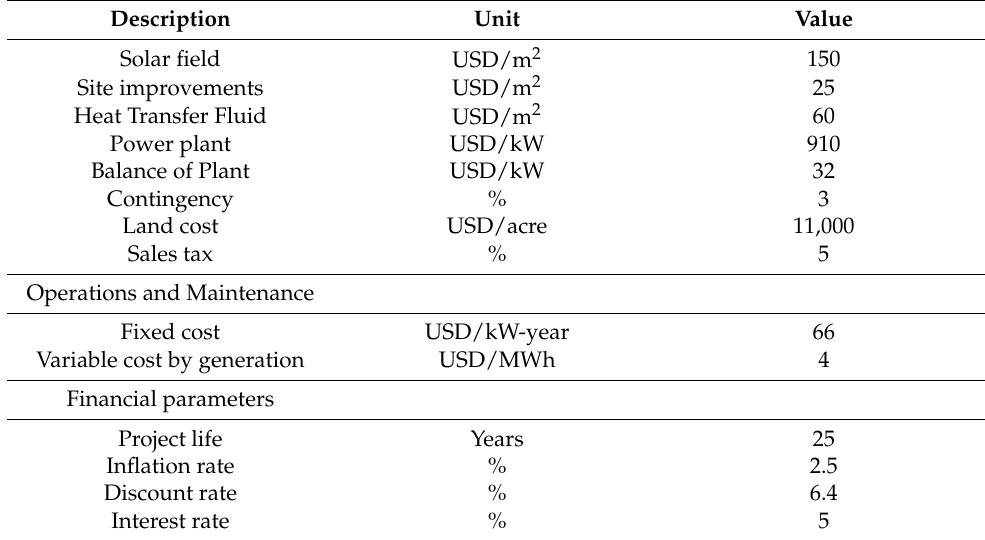
Table 11. Economic parameters for CSP. Data from